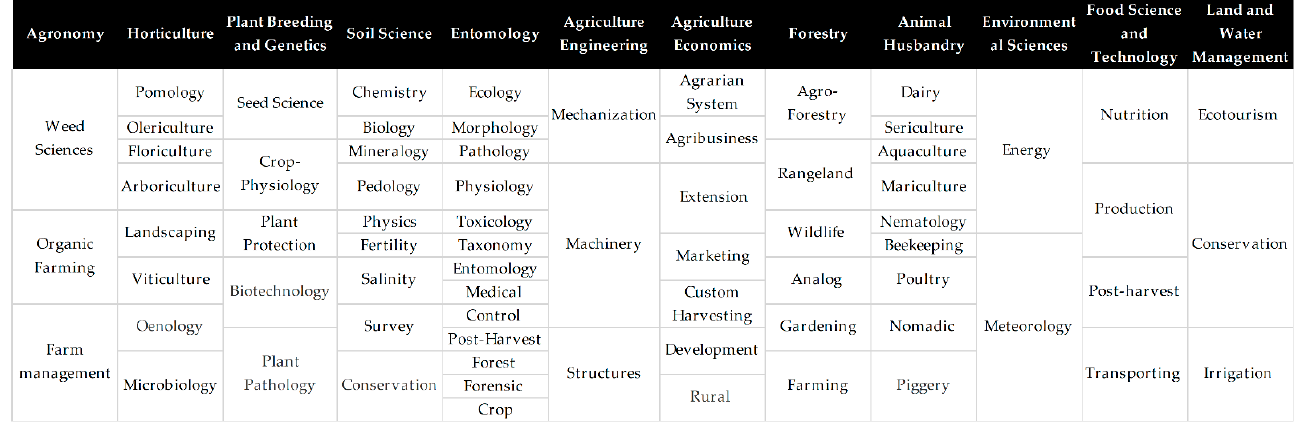
Figure 1. Disciplines and subdisciplines in agriculture [3].